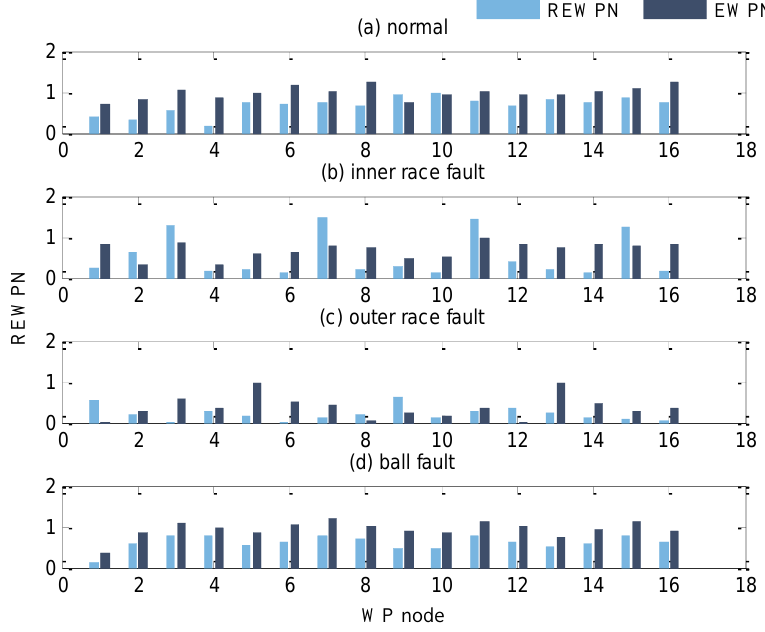
Figure 4. The normalized wavelet packet energy and entropy spectrums of the bearing vibration signals under four conditions: ( a ) normal condition, ( b ) inner race fault, ( c ) ball fault, ( d ) outer race fault.